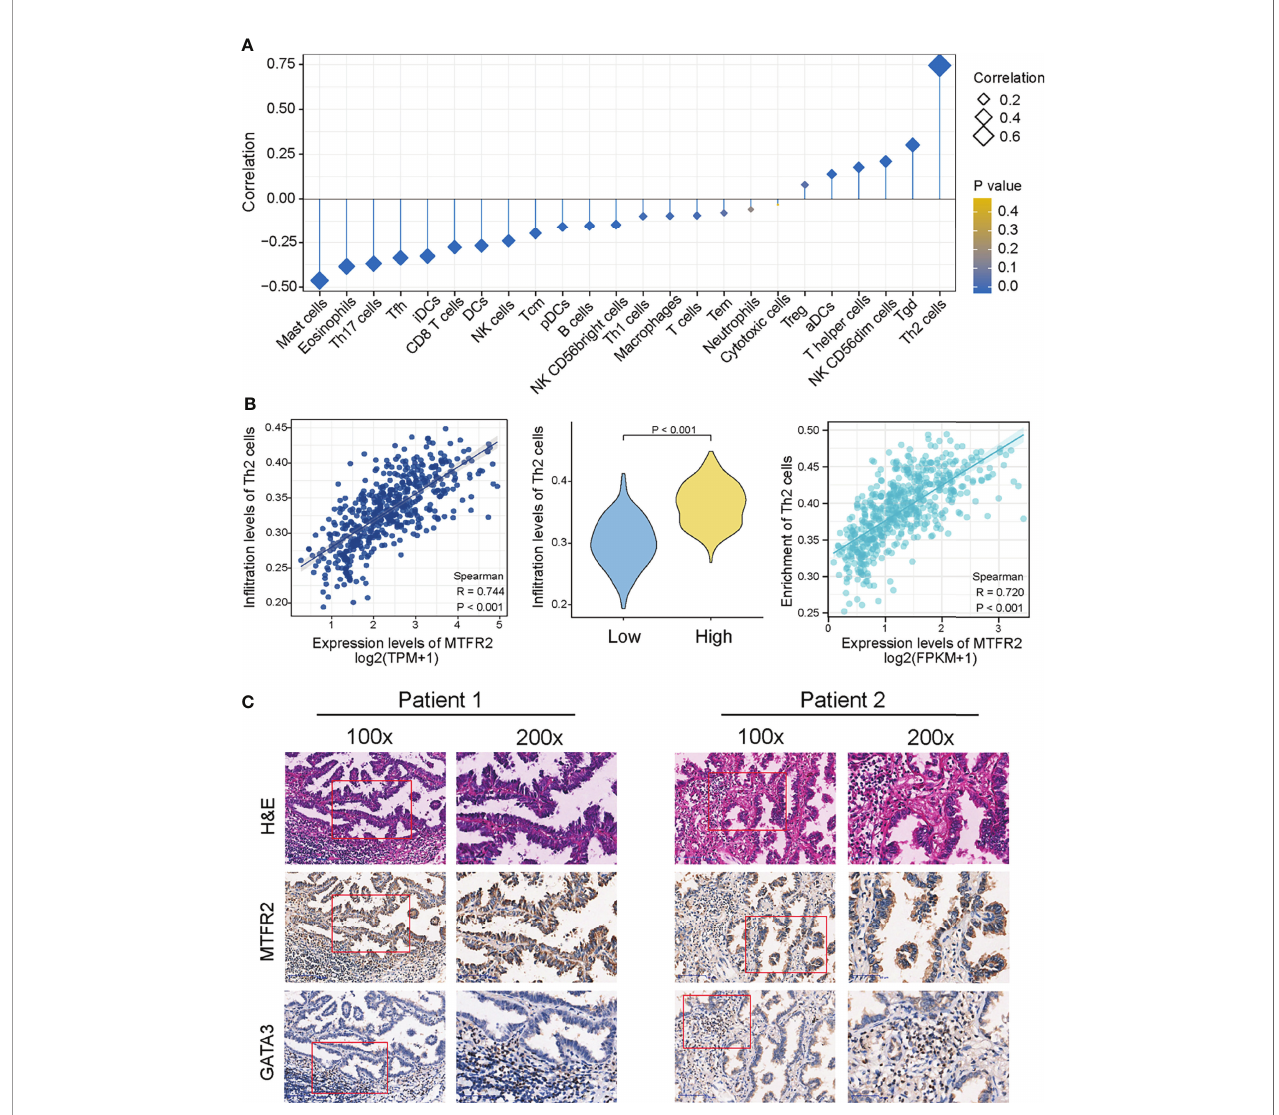
FIGURE 6 | MTFR2 overexpression was correlated with the immune in fi ltration in the tumor microenvironment. The forest plot showed the correlation between MTFR2 expression and 24 immune cell subsets (A) . Correlation between the Th2 cells and the expression level of MTFR2 (B) . Immunochemistry showed the correlation of MTFR2 expression and Th2 cell biomarker GATA3 (C)